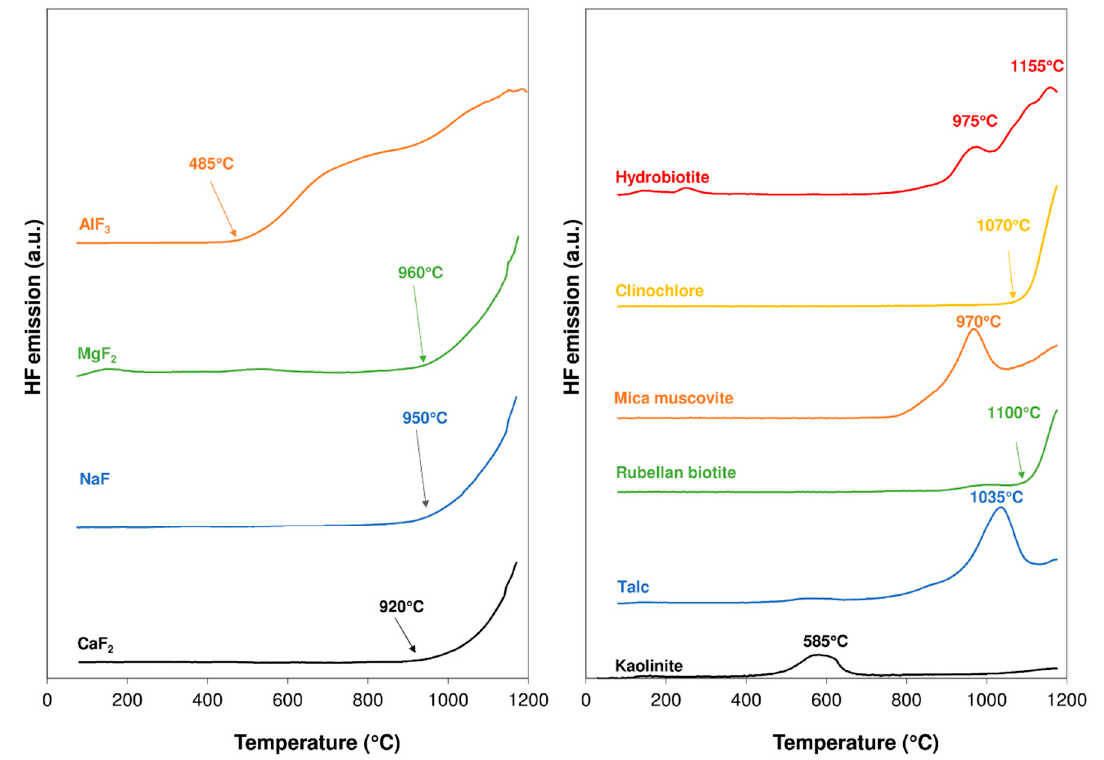
Figure 2. HF emission evolution of analyzed samples.